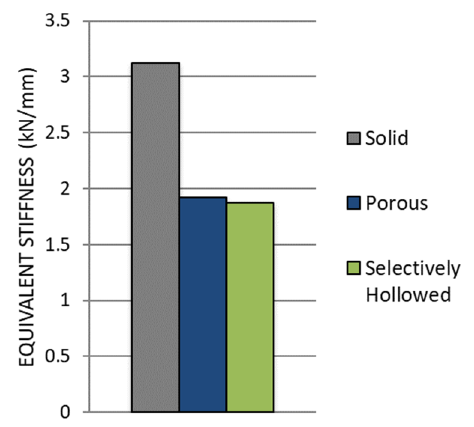
Figure 11. Comparison of experimental stiffness measurements for the solid reference, porous and selectively hollowed implant measured experimentally.